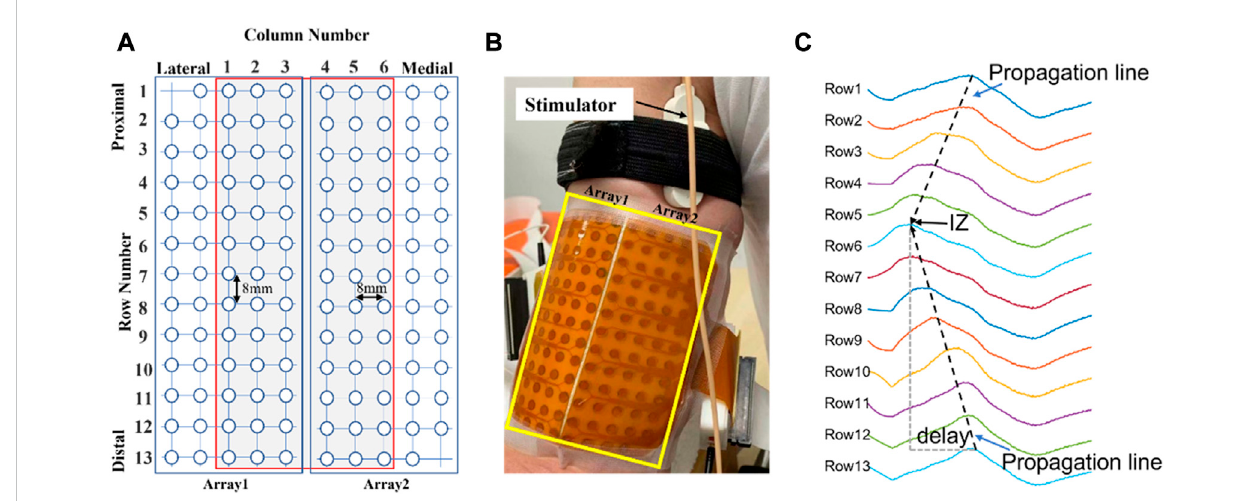
FIGURE 1 (A) : Schematic representation of the two adhesive 2D matrices for recording experimental signals. (B) : High-density electrode array recording with columns positioned parallel to the muscle fi ber direction. (C) : An example of monopolar M waves of 13 channels in one of the columns from a representative subject. The IZ is located close to row 6. Delay: time interval of the waveforms travelling distally from the IZ.